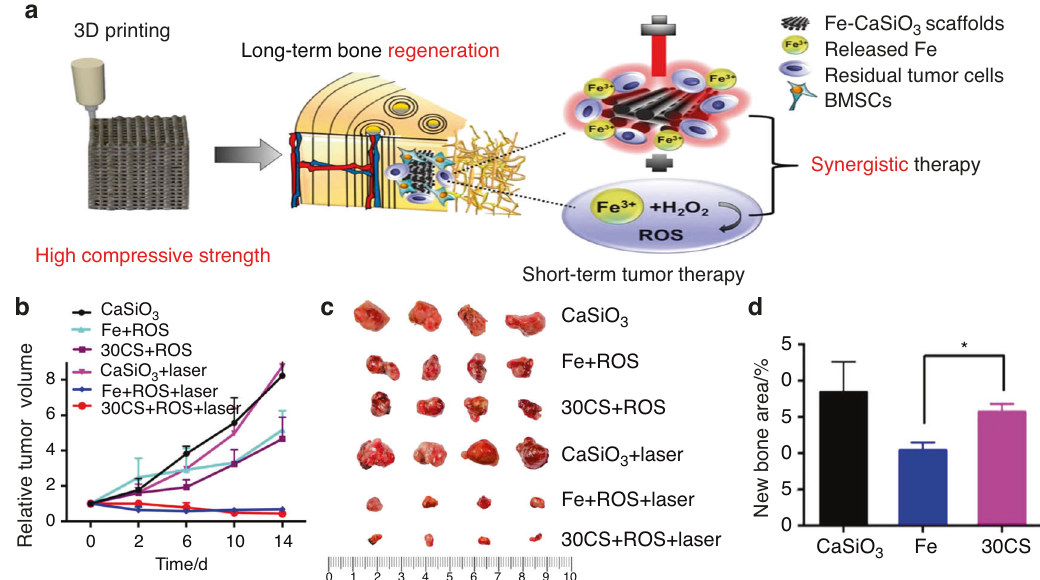
Fig. 8 3D printing of high-strength bioscaffolds for the synergistic treatment of bone cancer. a Scheme of the synthesis of Fe-CaSiO 3 composite scaffolds and their biomedical application. b Changes of the relative tumor volume in the six groups. c Photos of the tumors in six different groups on day 15. d The histomorphometric measurements of the in vivo new bone area in three groups at 8 weeks post-surgery (* P < 0.05). Reproduced with permission. 105 Copyright 2018, Nature Publishing